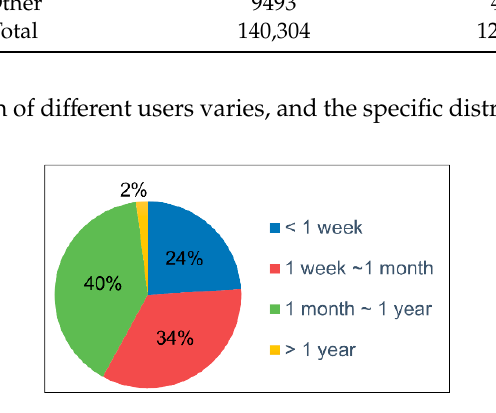
Figure 2. Duration of user data collection.